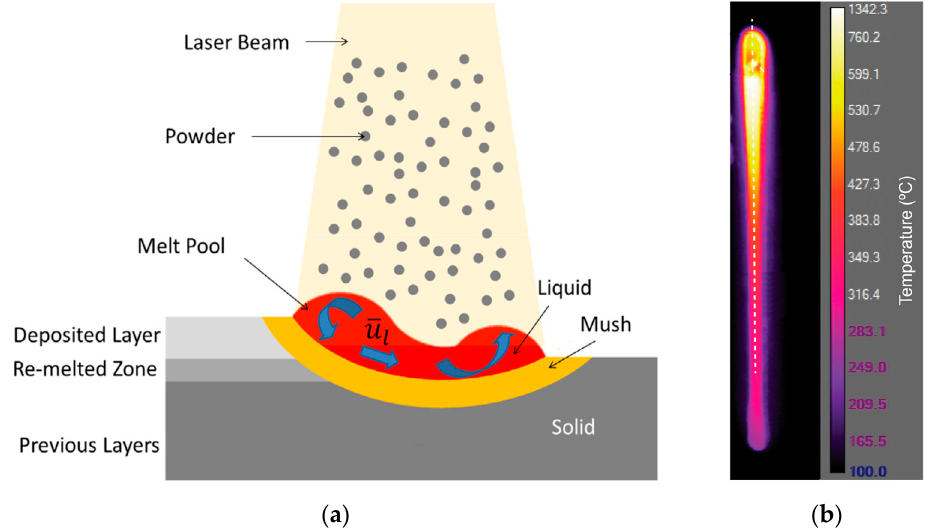
Figure 17. ( a ) Schematic representation of the melt pool generation (reproduced with permission from [74]; Copyright © 2015 Elsevier) and ( b ) thermal image captured during the deposition of 316L thin wall (reproduced with permission from [89]; Copyright © 2022 Elsevier).